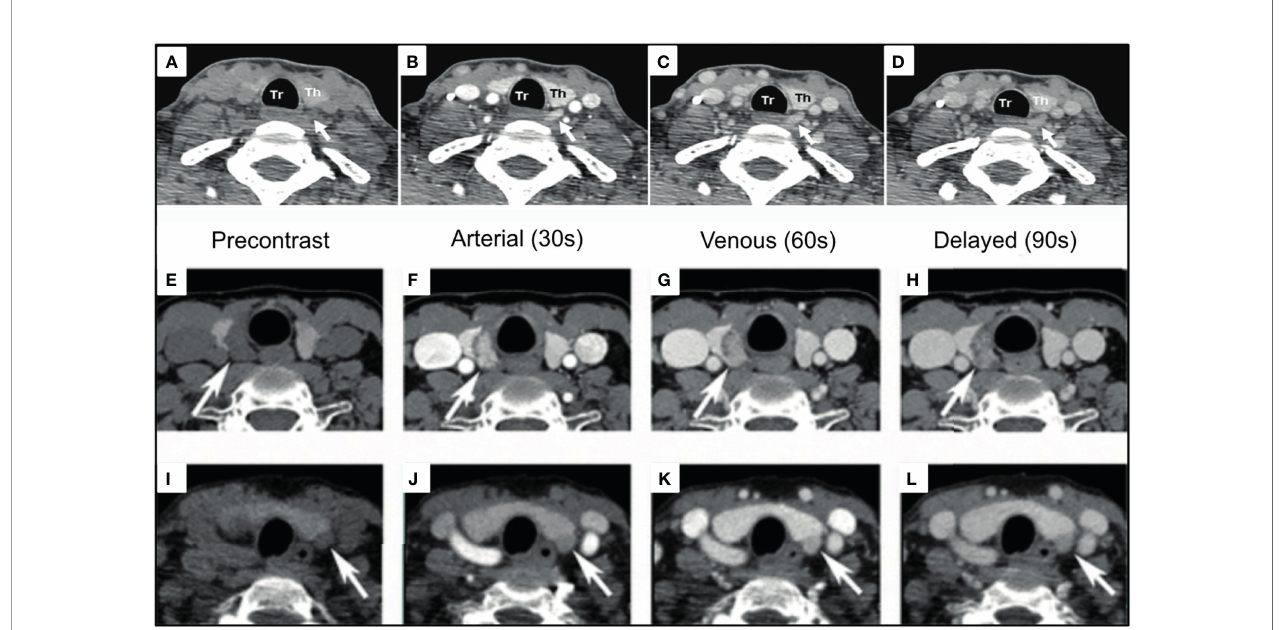
FIGURE 8 | 4DCT imaging of parathyroid adenomas. Left PA [ (A – D) , white arrows] and Right PA [ (E – H) , white arrows] are visualized as arterially enhancing soft- tissue structures adjacent to the thyroid, which wash out on subsequent phases. Left PA [ (I – L) , white arrows] with progressive enhancement greatest on the venous phase demonstrating enhancement characteristics can be variable. Reproduced with permission: (A – D) Mahajan A, Starker LF, Ghita M, Udelsman R, Brink JA, Carling T. Parathyroid four-dimensional computed tomography: evaluation of radiation dose exposure during preoperative localization of parathyroid tumors in primary hyperparathyroidism. World J Surg. 2012 Jun;36(6):1335-9. doi: 10.1007/s00268-011-1365-3. PMID: 22146947. (E – L) Lee EK, Yun TJ, Kim JH, Lee KE, Kim SJ, Won JK, Kang KM, Choi SH, Sohn CH. Effect of tumor volume on the enhancement pattern of parathyroid adenoma on parathyroid four-dimensional CT. Neuroradiology. 2016 May;58(5):495-501. doi: 10.1007/s00234-016-1656-3. Epub 2016 Feb 5. PMID: 26847704